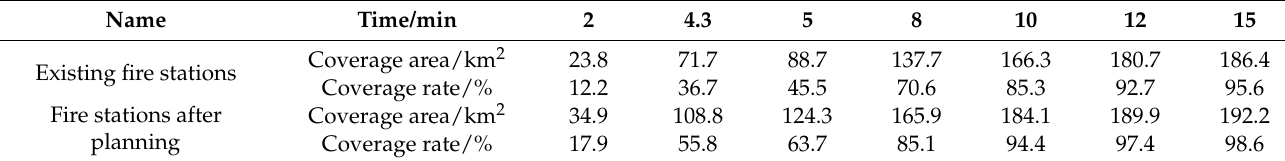
Figure 10. Accessible area of fire stations at different times after planning. ( a ) Accessibility of existing fire stations. ( b ) Accessibility of fire stations after planning. Table 7. Coverage area of fire stations in different time